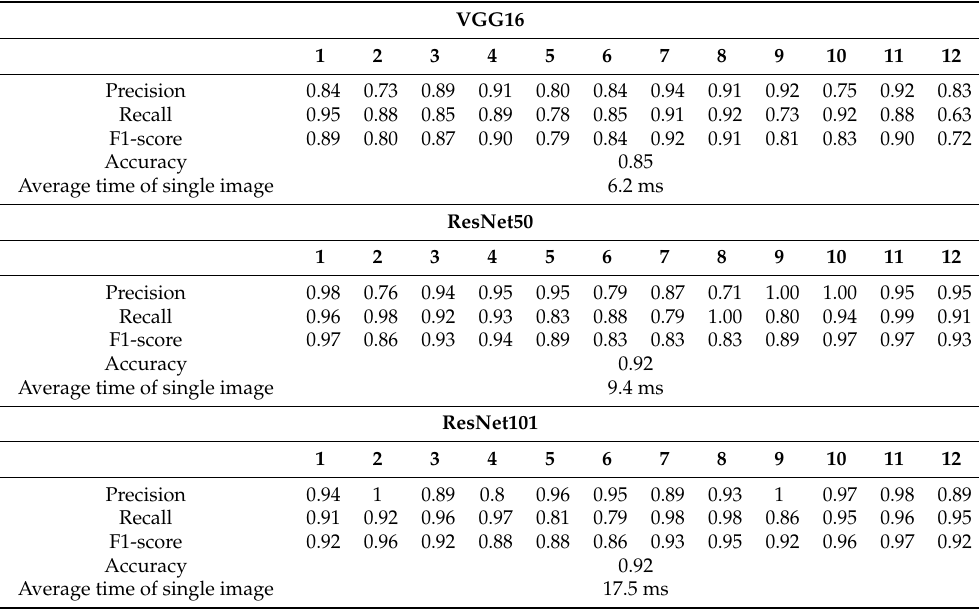
Table 7. Prediction matrix of different models applied in identification of “Wood AUTH”